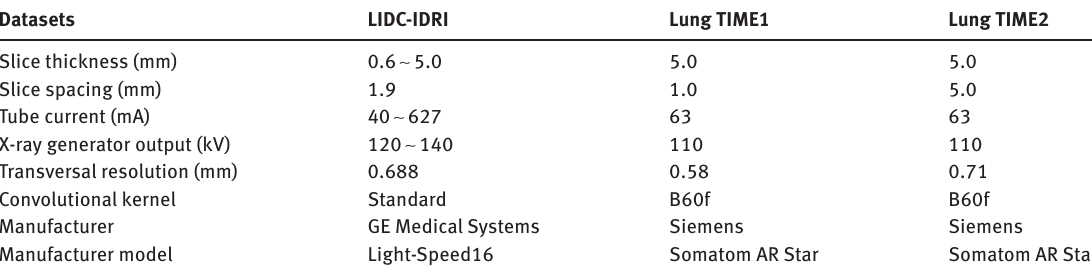
Table 1: Significant Parameters of